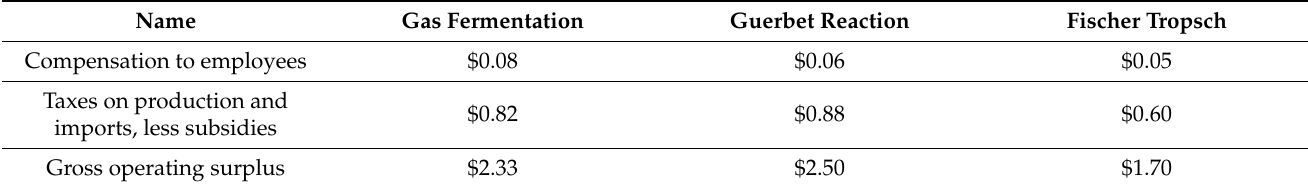
Table A3. Value added in 2012 USD per GGE for each technology to produce woody-based biofuels.